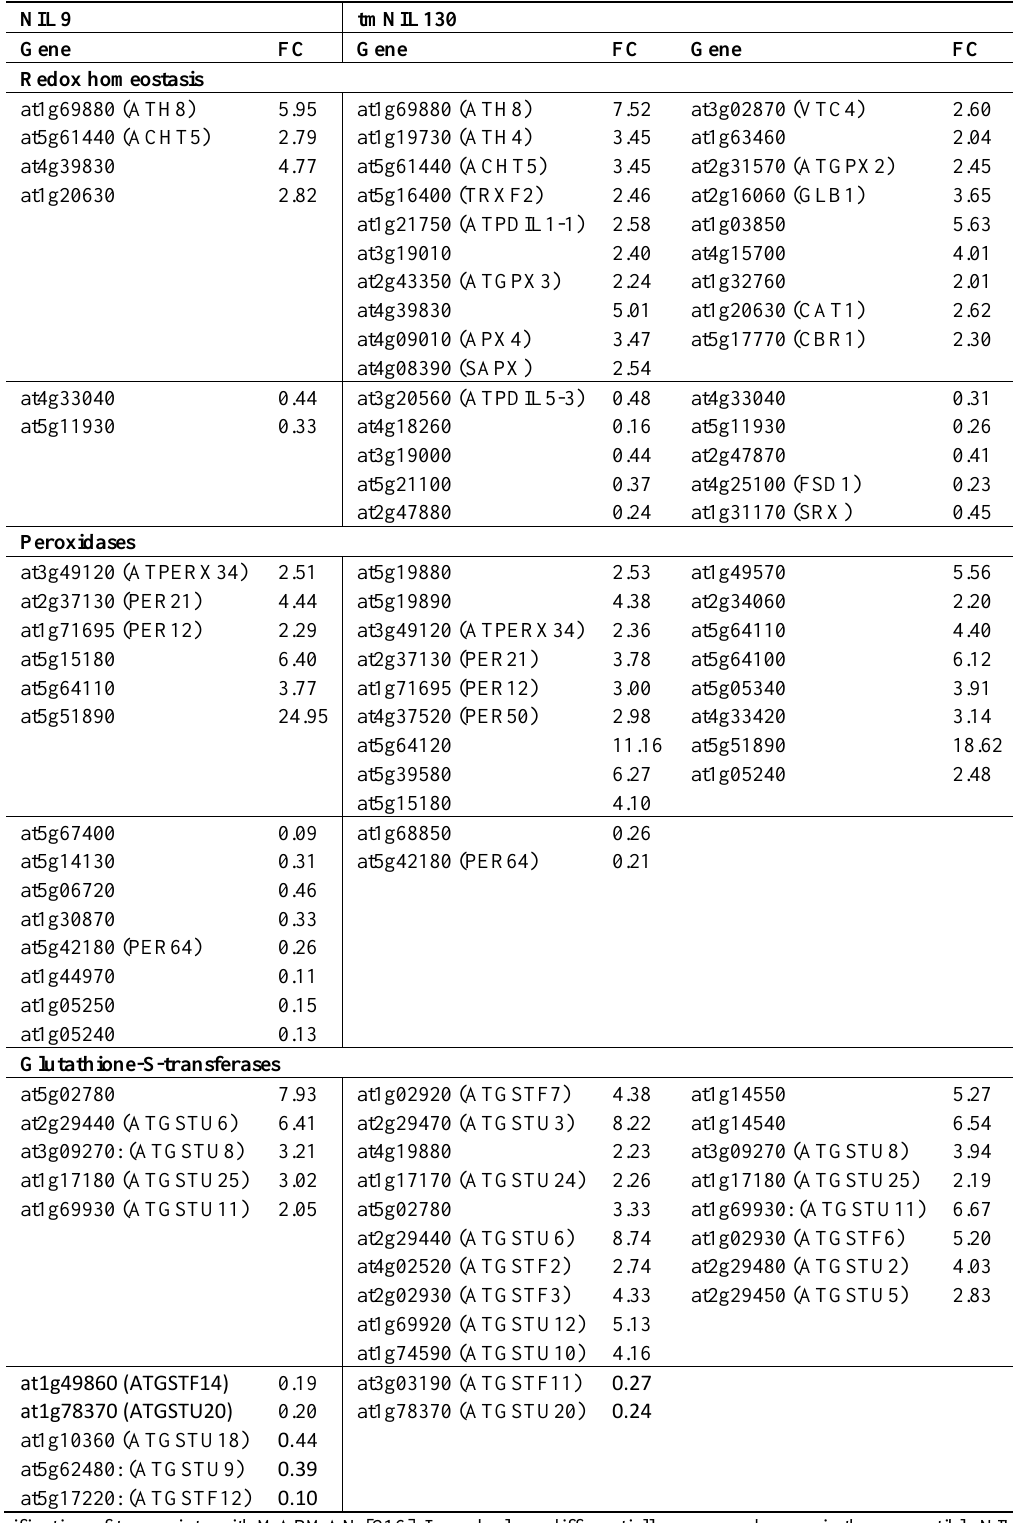
Classification of transcripts with MAPMAN [216]. In each class, differentially expressed genes in the susceptible NIL9 are displayed on the left side, those in resistant tmNIL130 on the right side. Up-regulated genes are at the top of each group, down-regulated genes at the bottom. Only those transcripts were included whose fold change (FC) was over 2 or below 0.5. Means for transcripts (represented by transcript clusters in AraGene-1_1-st microarrays) were calculated from individual probeset values, for which the cutoff was set at p <